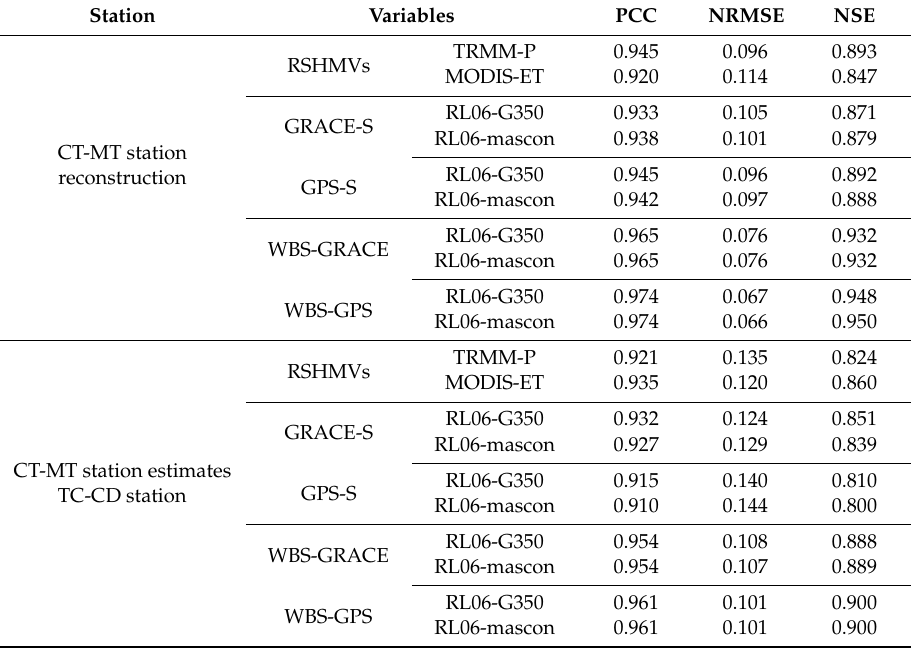
Figure 5. Reconstructed runoff based on remotely-sensed (a) precipitation (TRMM-P), (b) evapotranspiration (MODIS-ET), (c) water storage (GRACE-S), and (d) GPS-inferred water storage (GPS-S) with a 350-km Gaussian Filtering (G350) from CSR RL06 solution, and (e) water storage (GRACE-S) and (f) GPS-inferred water storage (GPS-S) from CSR RL06 mascon solution (Mascon) at Can Tho and My Thuan (CT-MT) station. Table 2. Internal assessment for reconstructed runo ff at Can Tho–My Thuan (CT-MT), and external assessment for estimated runo ff at Tan Chau–Chau Doc (TC-CD) using the determined parameters during runo ff reconstruction at Can Tho–My Thuan